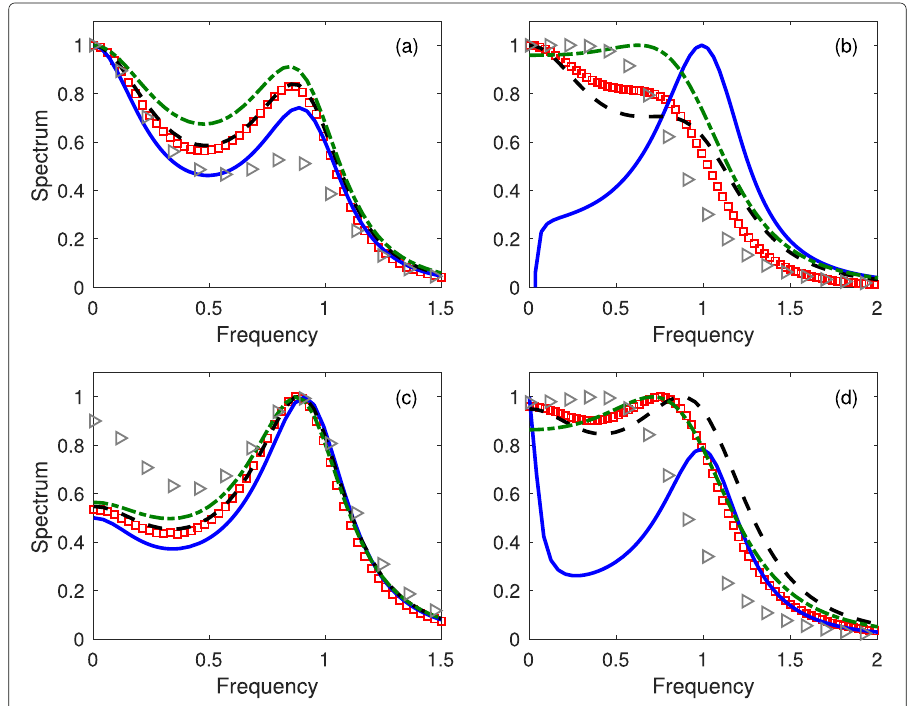
Fig. 4 Spectra of the spontaneous ( a , b ) and coherent ( c , d ) RBS, when ( a , c ) Kn = 0.05 and ( b , d ) Kn = 0.1. Solid, dashed, and dash-dotted lines are the results from super-Burnett equations with θ 7 = − 157 / 16, − 15 / 4 and 11 / 16, respectively. Triangles are results from the Woods’ equations